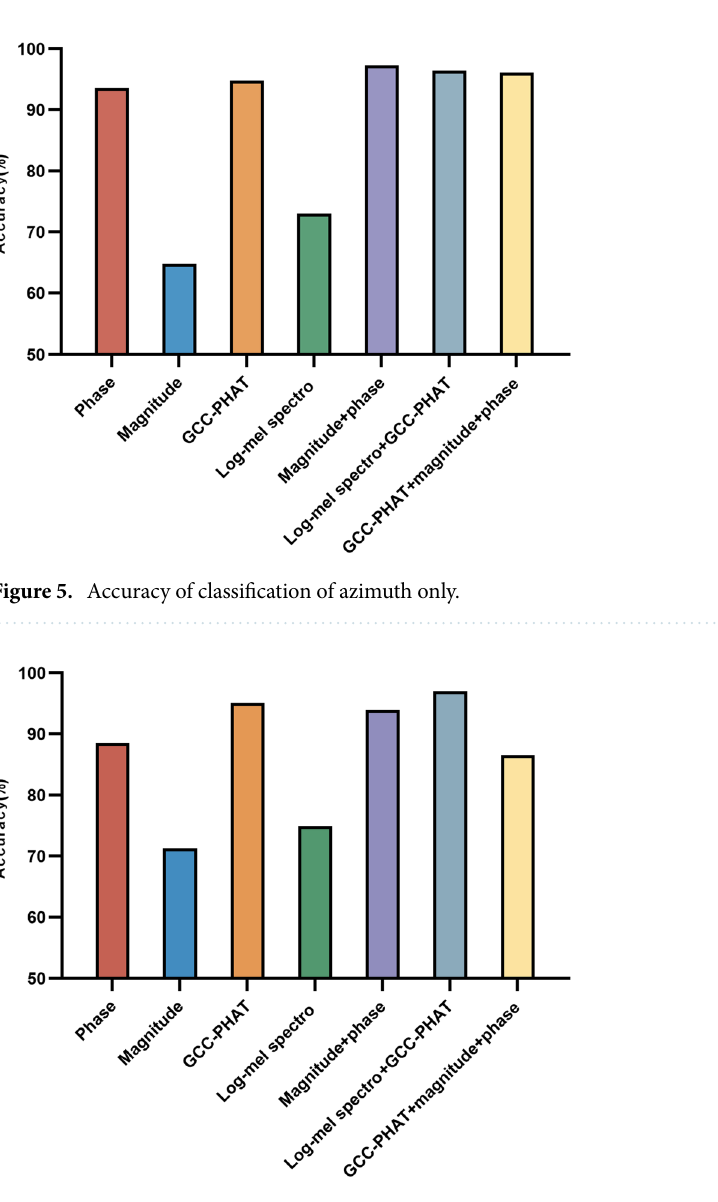
Figure 6. Accuracy of classification of elevation